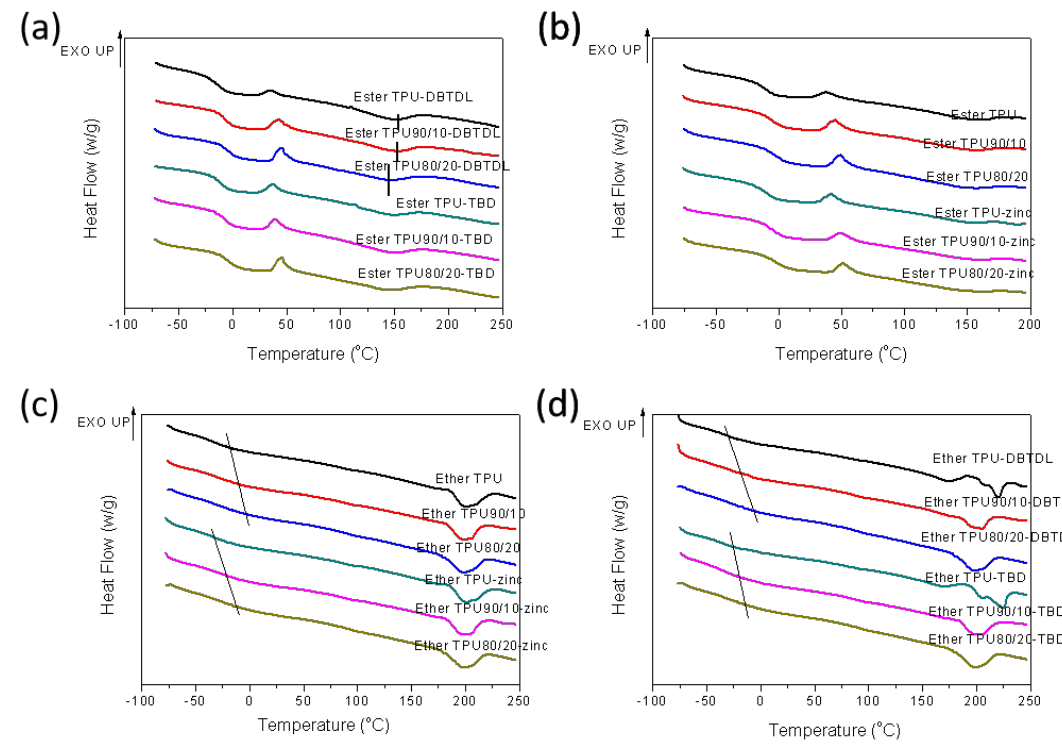
Figure 3. DSC curves for the TPU / phenoxy blends: ( a , b ) Ester TPU / phenoxy blends with di ff erent catalysts; ( c , d ) Ether TPU / phenoxy with di ff erent catalysts. Table 2. Thermal, mechanical and dynamic mechanical properties of TPU / phenoxy resin